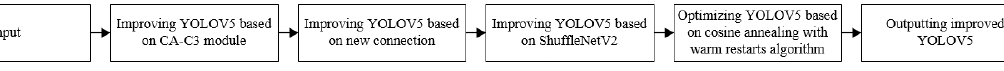
Figure 8. Flow chart of the proposed method.